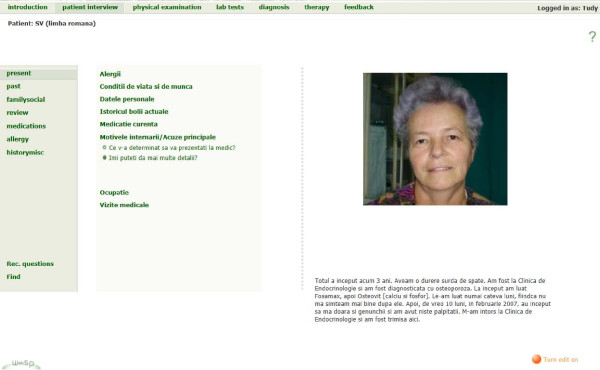
Silvia Vlasa, ROM.